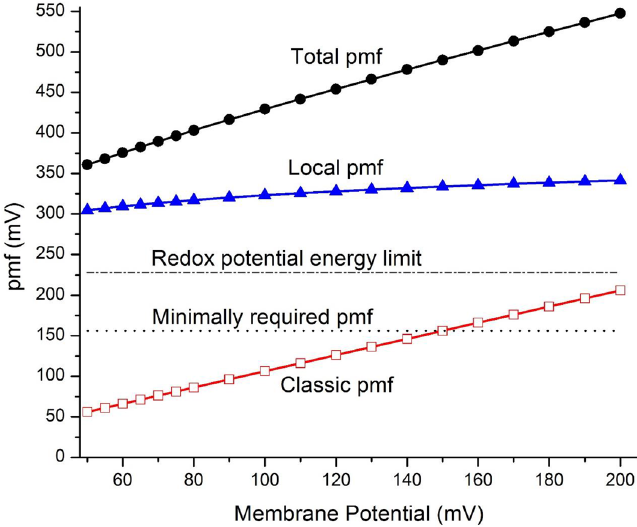
Figure 1. The values of total pmf, local pmf and classic pmf in mitochondria calculated as a function of membrane potential �ψ using the newly formulated pmf expression (Eqs. 2−4) in comparison with the minimally required pmf (156 mV) for ATP synthesis and with the redox potential chemical energy upper limit (228